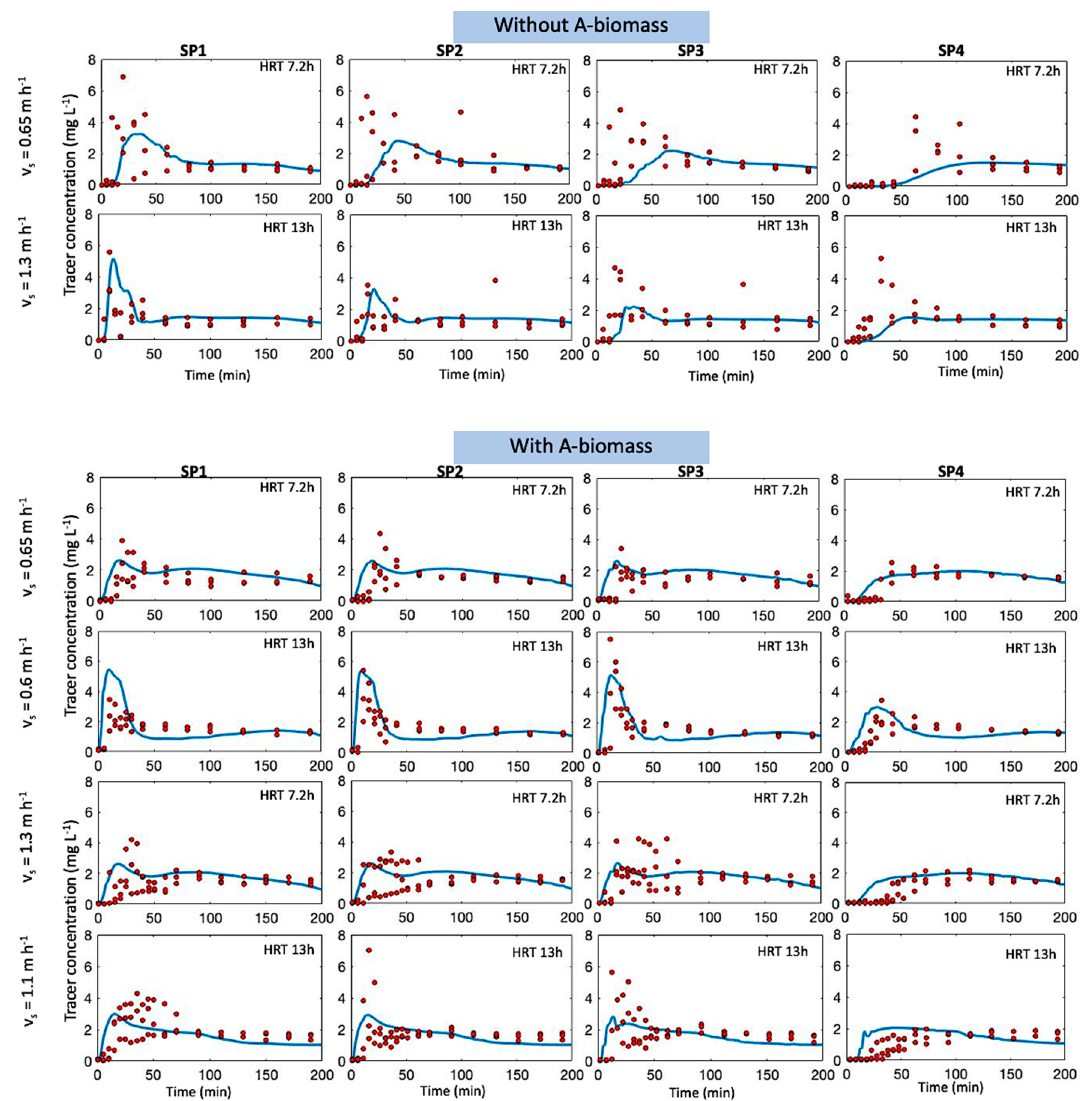
Figure 3. Comparison of the predicted (solid line) and measured concentration (red circles) at various heights (sampling ports, SP) for experiments with and without A-biomass.